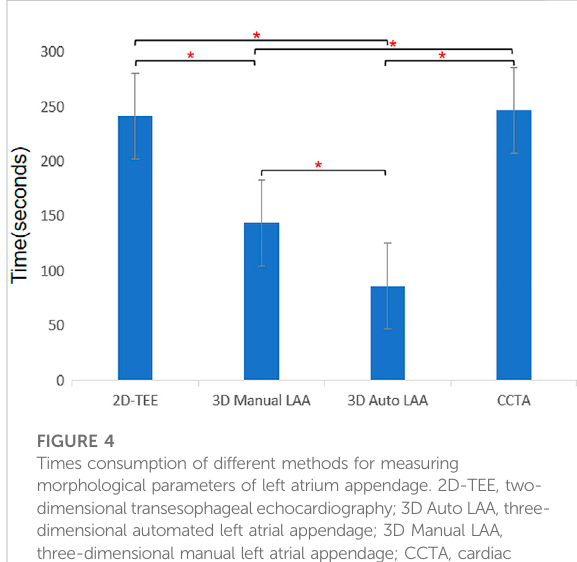
FIGURE 4 Times consumption of different methods for measuring morphological parameters of left atrium appendage. 2D-TEE, two- dimensional transesophageal echocardiography;3D Auto LAA, three- dimensional automated left atrial appendage; 3D Manual LAA, three-dimensional manual left atrial appendage; CCTA, cardiac computed tomographic angiography; * p- value < 0.05.